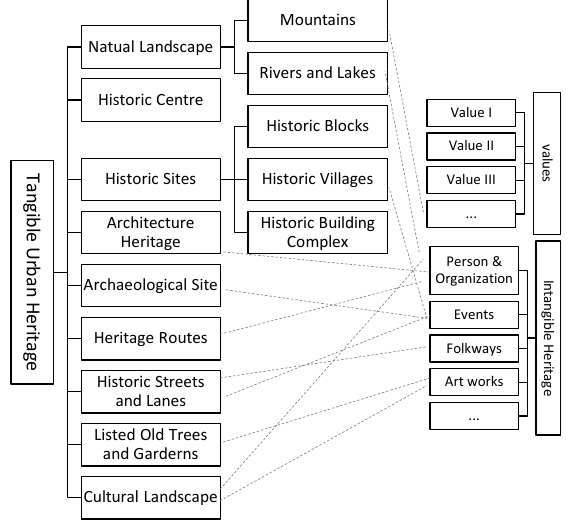
Figure 2. Schema of the urban heritage